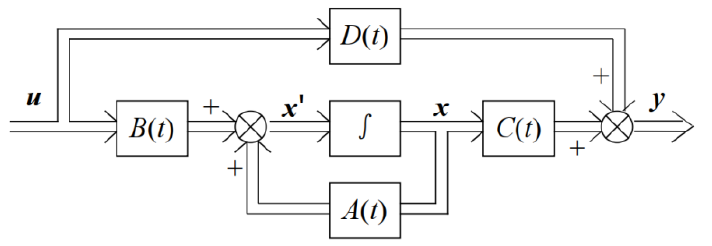
Figure 5. Structure diagram of MIMO linear time-varying system.